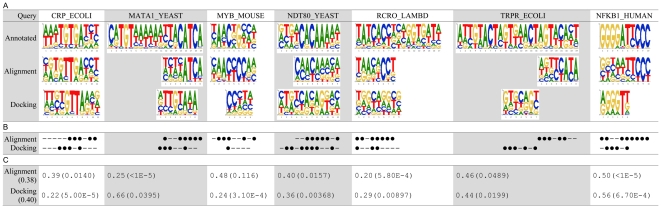
Comparison with predictions of using docking to construct synthetic complexes.The predictions based on the proposed alignment-based approach to construct synthetic complexes are denoted as ‘Alignment’, while those of ZDOCK are denoted as ‘Docking’. (A) PWMs. (B) A position is marked as ‘•’ if its most favorable base type was correctly predicted, or marked as ‘–’ otherwise. (C) Ψ-scores and the corresponding p-values. The value within the parentheses of the first column indicates the average Ψ-score.